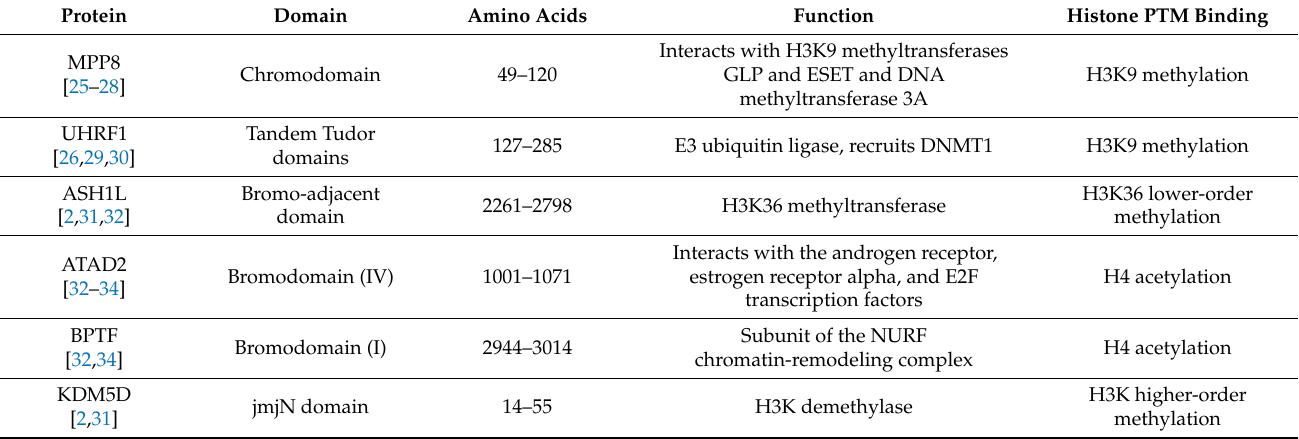
Table 1. Human protein domains used in experiments along with function and histone PTM binding